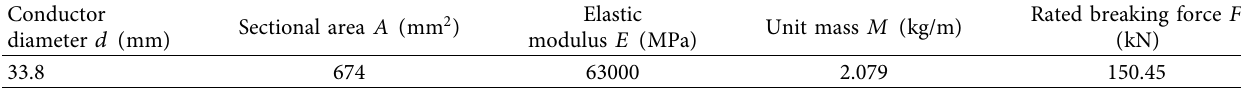
Table 4: Te conductor parameters of JL/GIA-630/45.